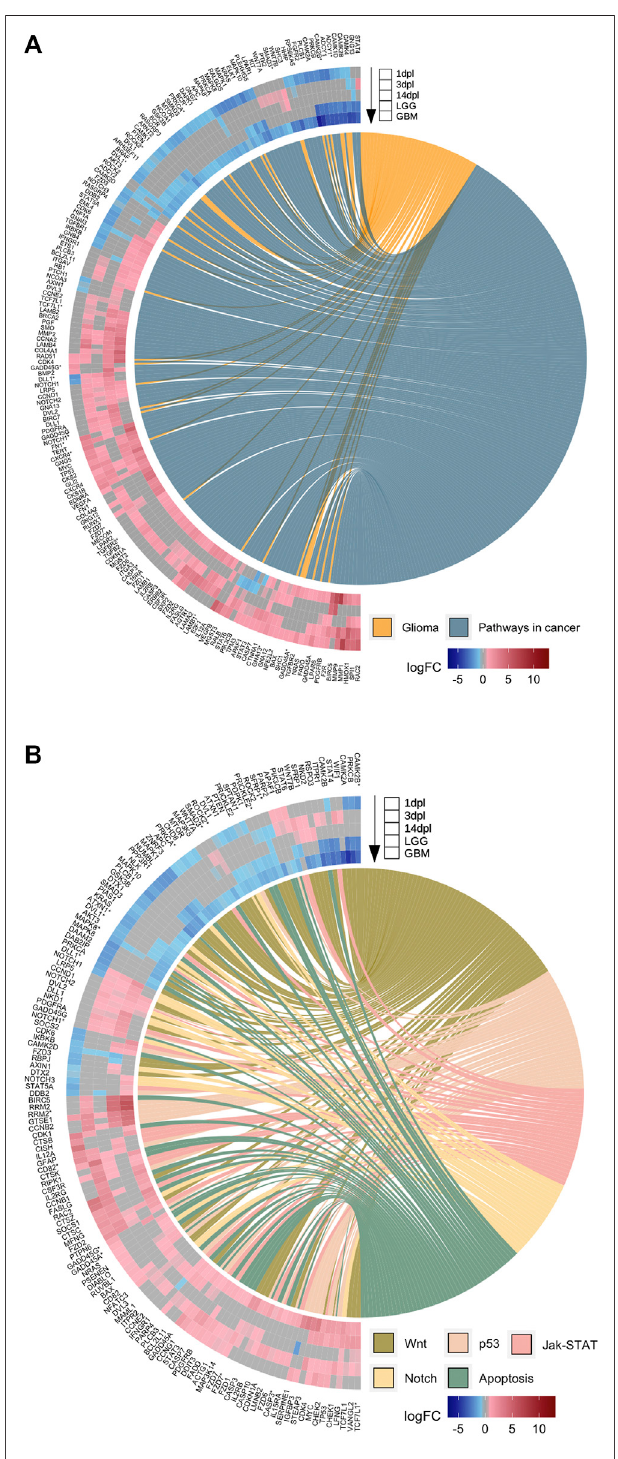
FIGURE 7 | linked to their assigned pathways by ribbons and ordered according to their log 2 fold change values from high to low regulation, represented by a color gradient from blue to red, respectively. log 2 fold changes are shown from the outer to the inner annulus in the following order: 1, 3, 14 dpl, LGG and GBM. An asterisk was appended to human genes associated as orthologs to several zebra fi sh genes in the list. dpl: days post- lesion, LGG: low-grade glioma, GBM: